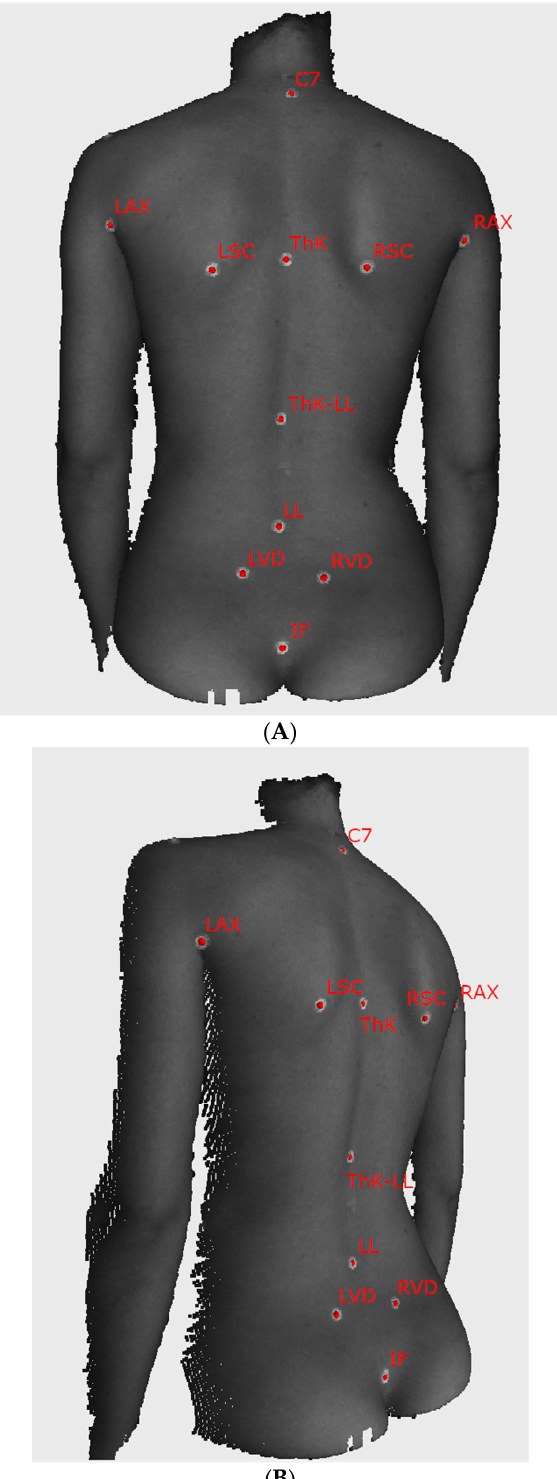
Figure 2. The sample images of the examined subject with self-adhesive markers on the skin (( A ) posterior view, ( B ) oblique view). Markers used in the analysis are captioned with the name of the corresponding anatomical structure. C7—the spinous process of the vertebra prominens, LAX/RAX—left and right axilla, LSC/RSC—the inferior angle of the left and right scapula, ThK—the apex of thoracic kyphosis, ThK-LL—point of transition from thoracic kyphosis to lumbar lordosis, LL—the apex of lumbar lordosis, LVD/RVD—left and right Venus dimple, IF—top of the intergluteal cleft.